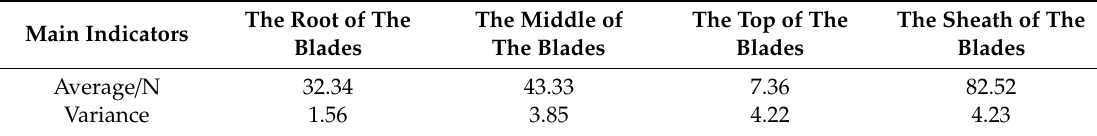
Table 4. Main data of two-point stretching of blades at room temperature.